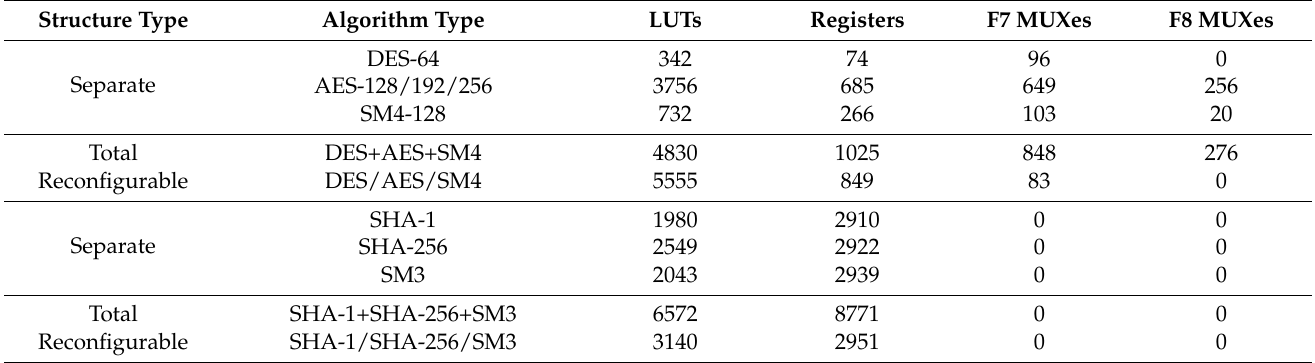
Table 8. Hardware overhead of the separate hardware implementation and the reconfigurable implementation of the three block ciphers and hash functions based on